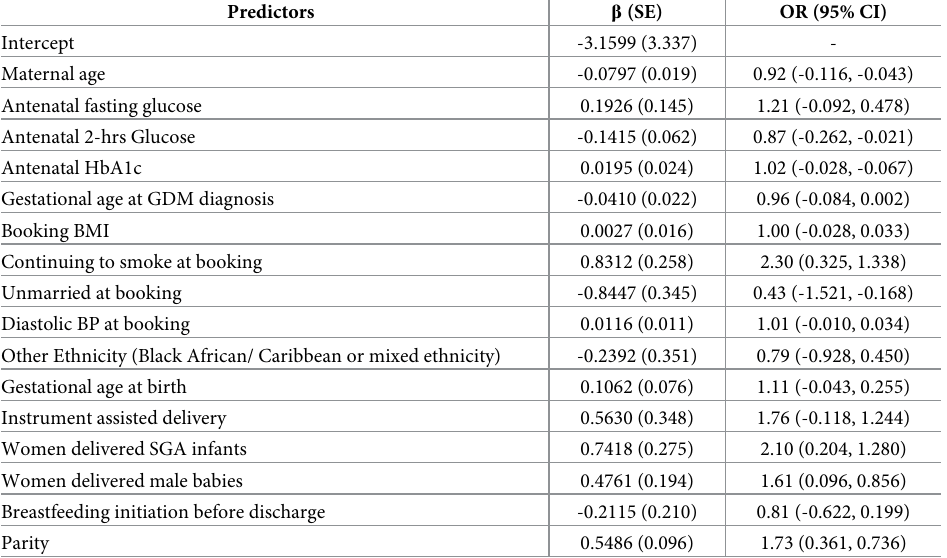
Table 2. Factors associated with non-attendance to postpartum screening identified by logistic regression.